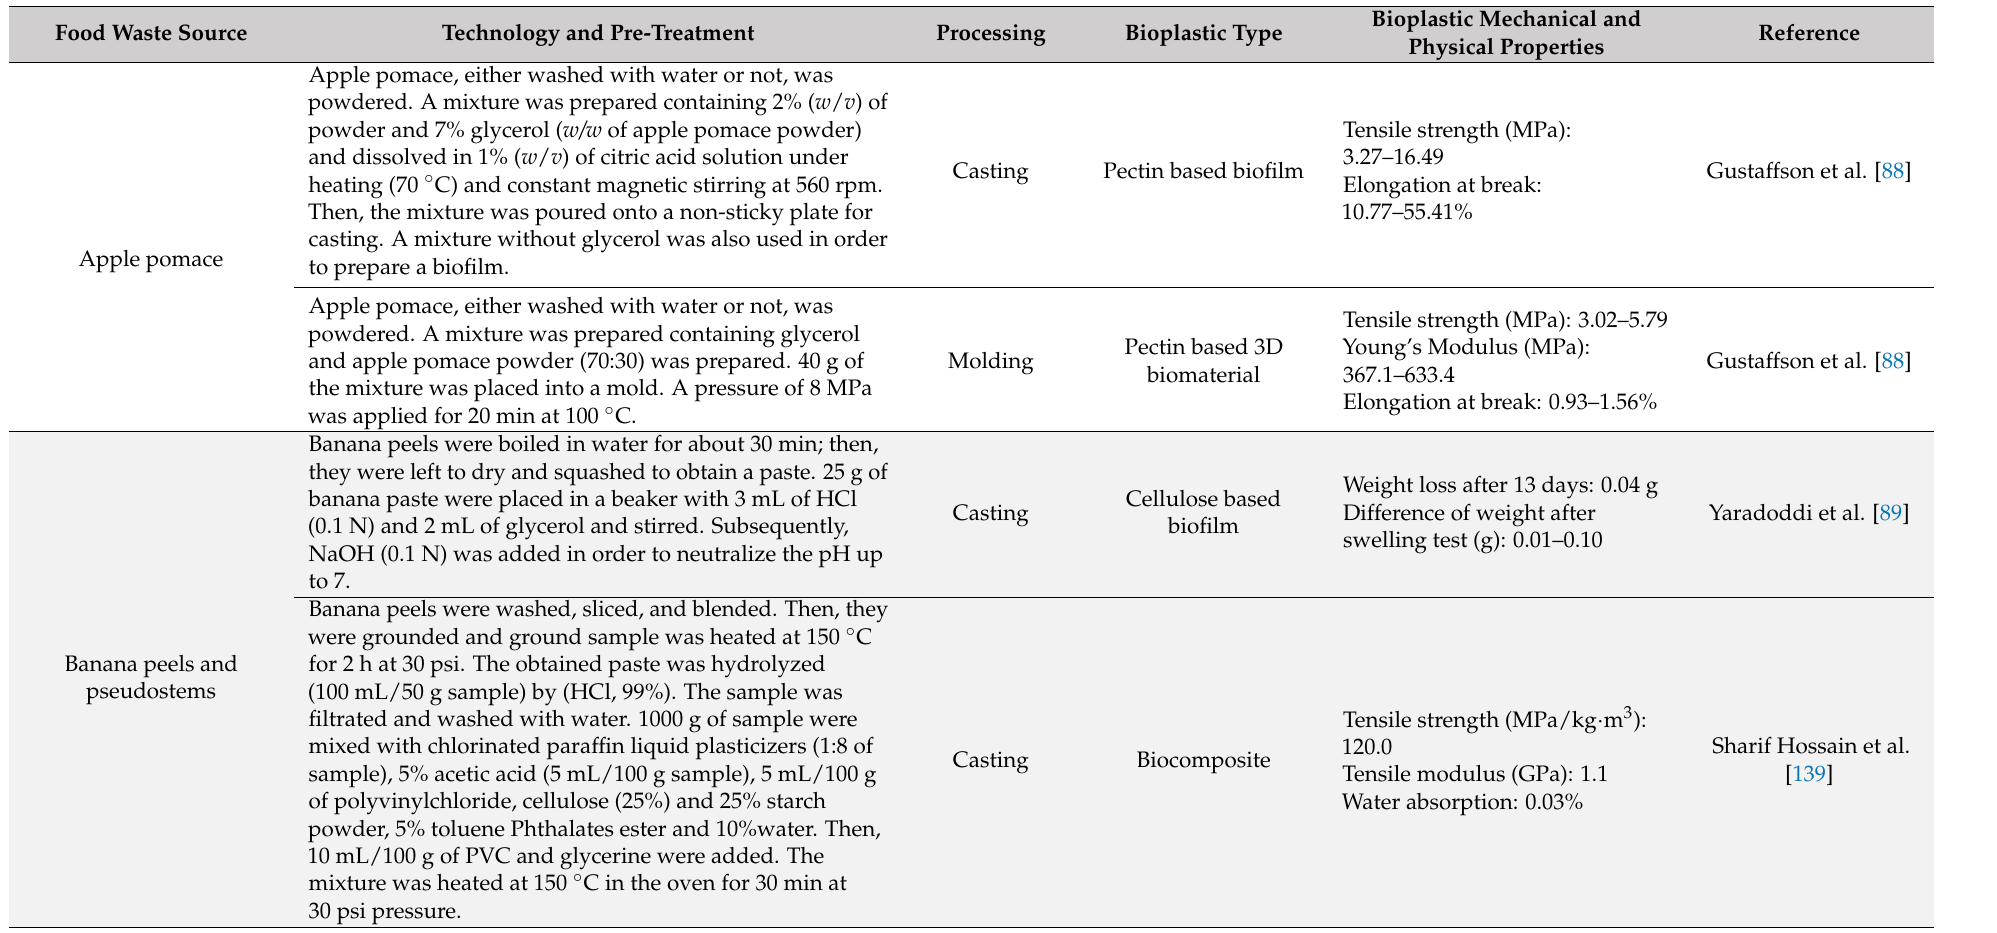
Table A1. Fruits and vegetables wastes used in the last 10 years as raw material for the production of bioplastics. A full description of the methods used for the production of bioplastics (Technology and pre-treatment of the waste, processing), as well as the main physical and mechanical properties of the obtained materials are provided. Food Waste